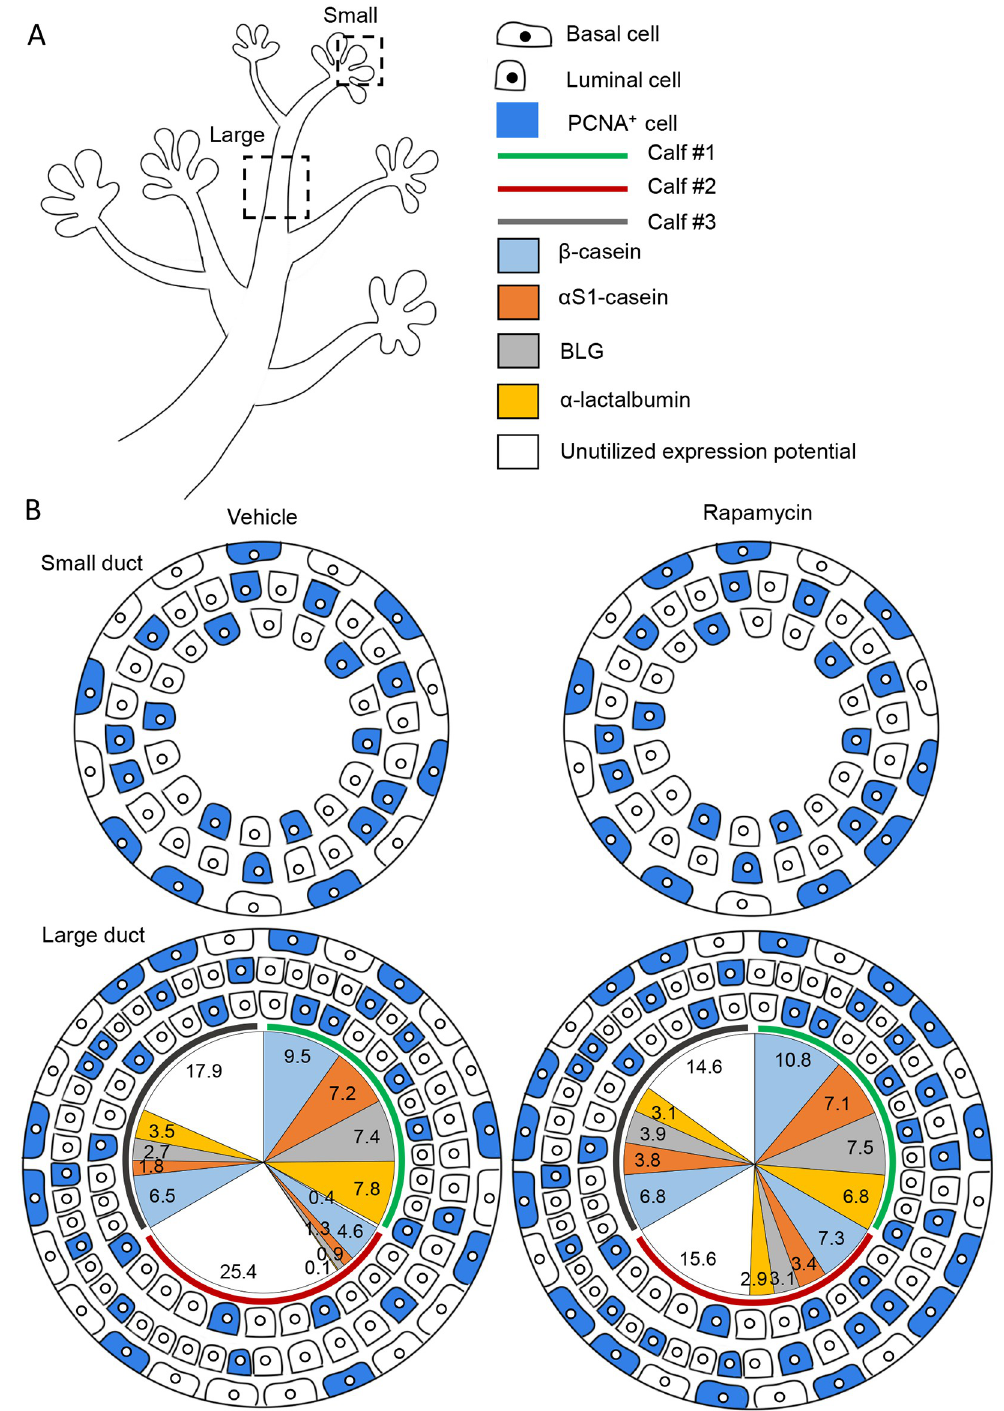
Fig 7. Scheme summarizing the latent effects of intramammary rapamycin administration on cell proliferation and milk protein gene expression. A. Representative small and large ducts in the developing mammary architecture are boxed. B. Basal and luminal cell proliferation in small and large ducts is presented in the outer three cell circles, where the relatively lower occupancy of basal cells in the small vs. large ducts can be visualized. Also demonstrated is rapamycin-induced cell proliferation in basal and luminal cells of the small ducts and only in luminal cells of the large ducts. The scheme is a precise representation of the relevant analyses. Milk protein gene expression in the mammary glands of the individual calves